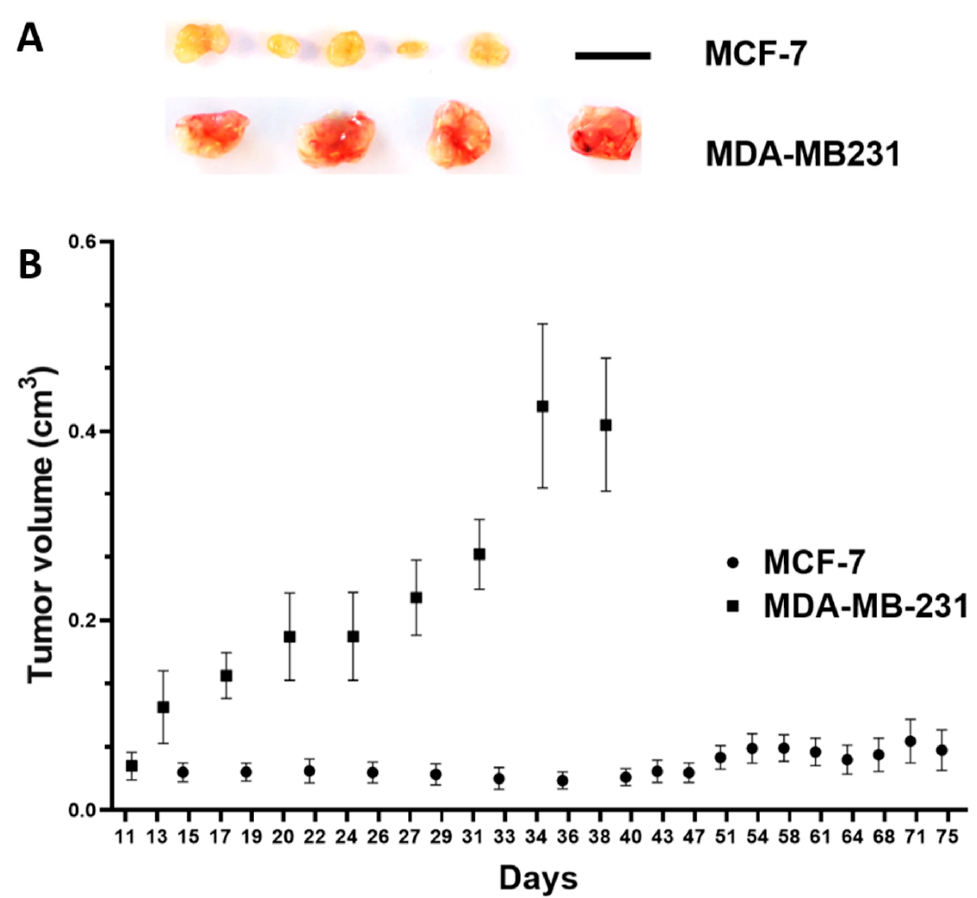
Figure 6. In vivo growth potential of MCF-7 and MDA-MB-231 breast cancer cells in the subcutaneous mouse model. ( A ) Resected tumor xenografts, scale bar: 1 cm (applies to both cell lines). ( B ) Tumor volume in cm 3 over time (days after inoculation of MCF-7 tumor cells ( n = 5 animals) and MDA-MB-231 tumor cells ( n = 4 animals); mean/standard error of the mean).